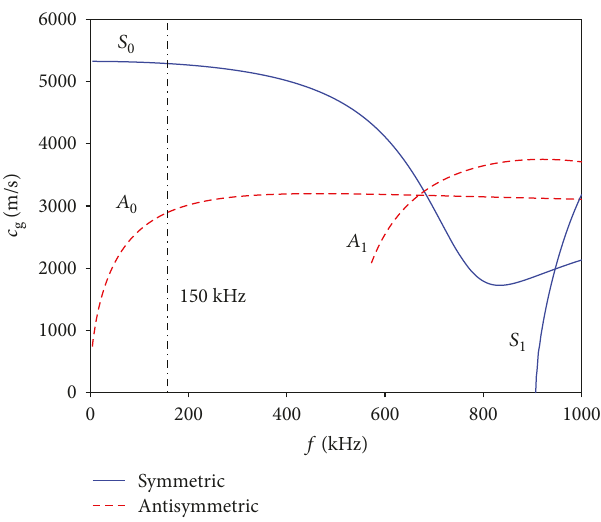
Figure 6: The group velocity dispersion plot of 3mm Q235 steel